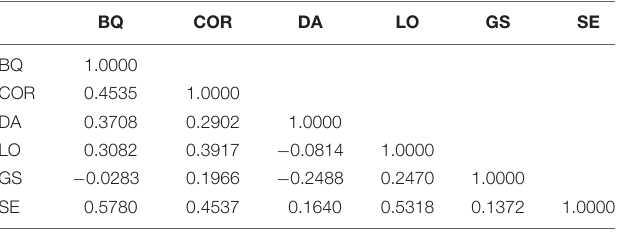
TABLE 4 | Correlation matrix of six individual institutional indicators.